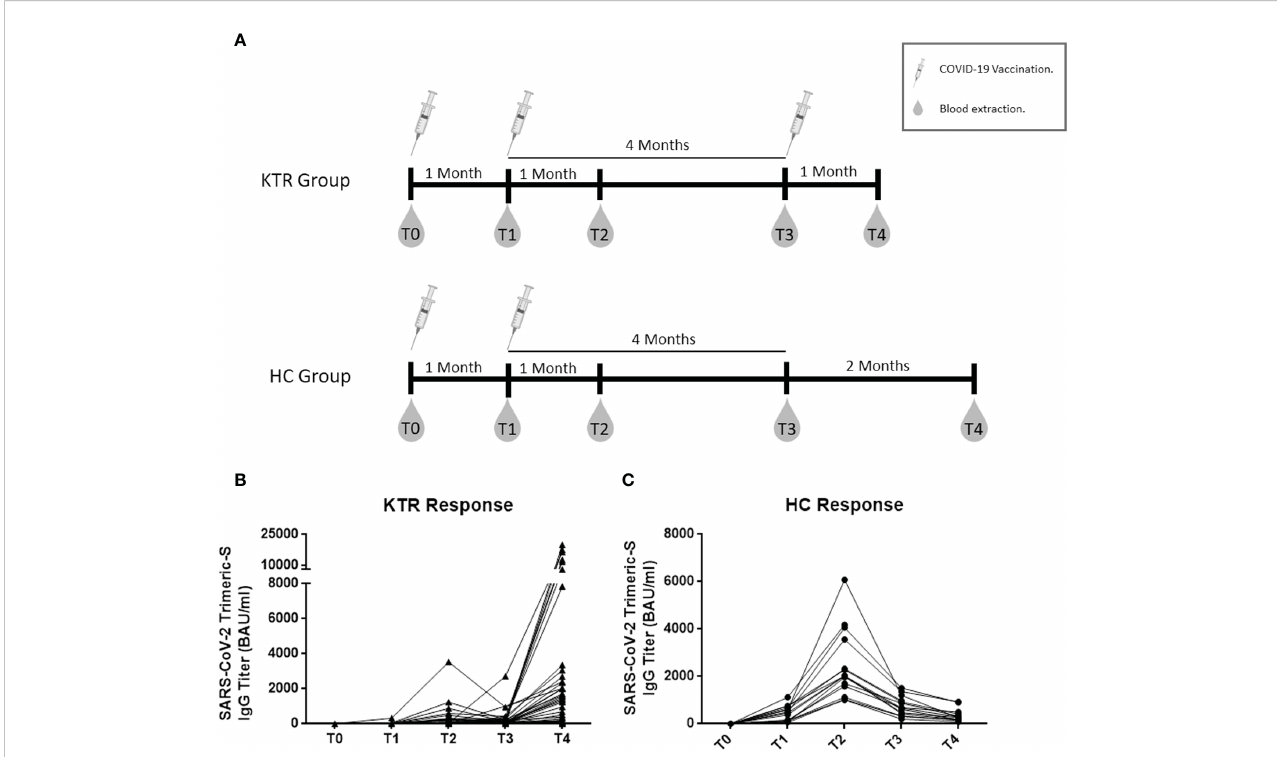
FIGURE 1 Follow-up of humoral response to COVID-19 vaccine, including design scheme of study design. Schematic study design and follow-up (A) , longitudinal follow-up of speci fi c antibody IgG titers in 54 Kidney transplant recipients receiving three doses of vaccine (B) and in Healthy controls receiving two doses of vaccine (C) . KTR, kidney transplant recipients; HC, healthy controls; T0, baseline; T1, one month after the fi rst dose and second dose administration; T2, one month after the second dose; T3, four months after the second dose and third dose administration in KTR group; T4, one month after the third dose. All comparison between time-points were statistically signi fi cant by Friedman test ( p